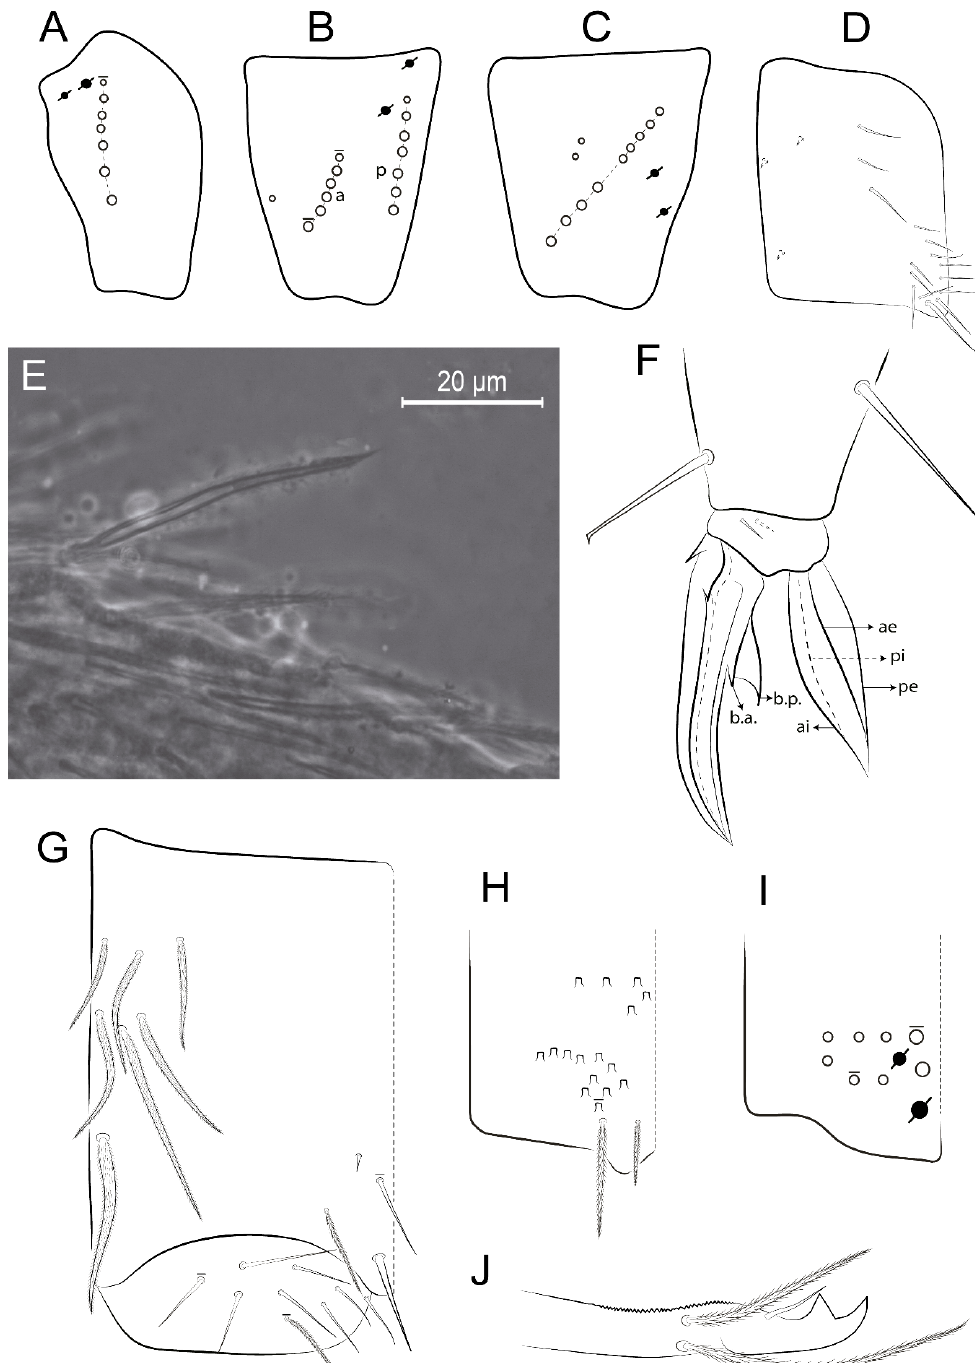
Figure 39. Pseudosinella alfanjeunguiculata sp. nov.: trunk appendages. ( A–C ) subcoxa I–III, respectively; ( D ) trochanteral organ; ( E ) modified chaeta of tibiotarsus III; ( F ) distal tibiotarsus and empodial complex III (anterior view); ( G ) collophore (lateral view); ( H ) distal part of manubrium (ventral view); ( I ) manubrial plate (dorsal view); ( J ) distal dens and mucro (inner view).